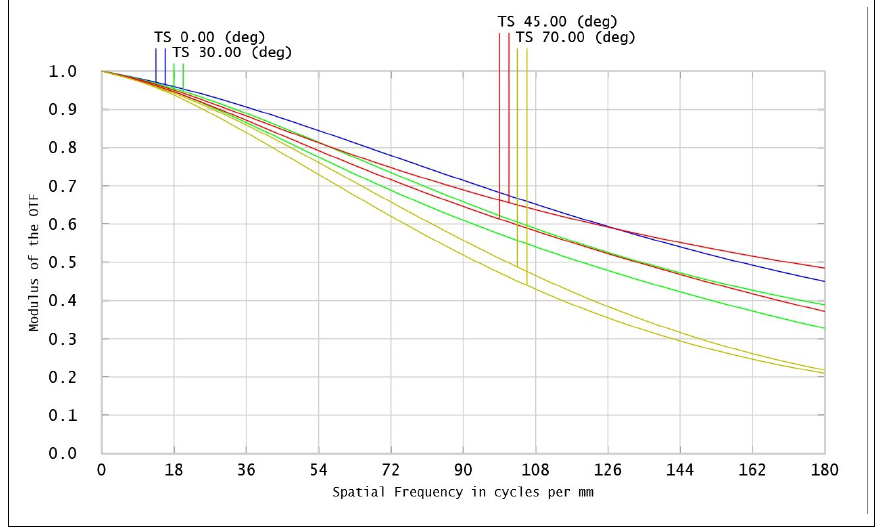
Figure 2. Modulation transfer function (MTF) of the optimized